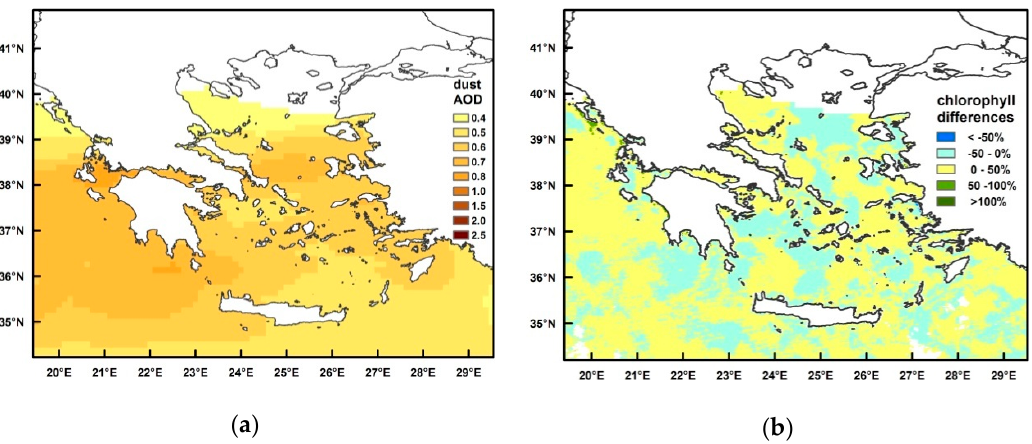
Figure 5. ( a ) Maximum dust AOD during the episode 6-8 September 2015; ( b ) Chl-a %